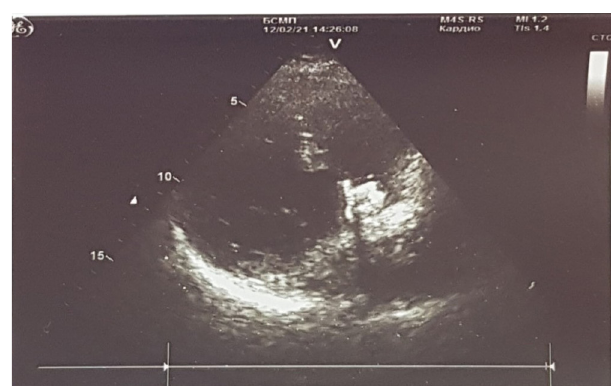
Fig. 2 - Echocardiography one month after